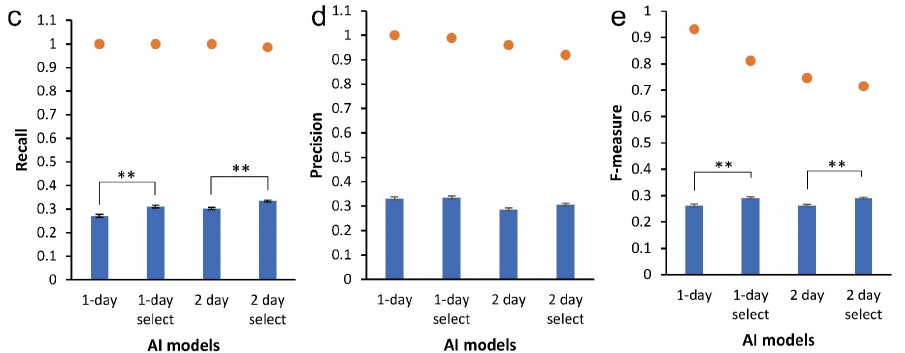
Figure 2. CSC image mapping from bright-field cell images. ( a ) Output examples by AI models trained with datasets of 1-day and 1-day-selected for an input phase-contrast image. Numbers in output images were F-measure values between output and target images of GFP fluorescence. Bar = 100 µ m. ( b ) Output examples for datasets of 2-day and 2-day-selected. Bar = 100 µ m. ( c – e ) Comparison of AI models trained with various datasets. Bright-field cell images chosen for AI to make outputs were taken from the same dataset category used for training the AI model. The values for recall ( c ), precision ( d ), and F-measure ( e ) were calculated. Closed circles indicate maximum values. Mean ± S.E.M., n = 1000. ** p < 0.01.